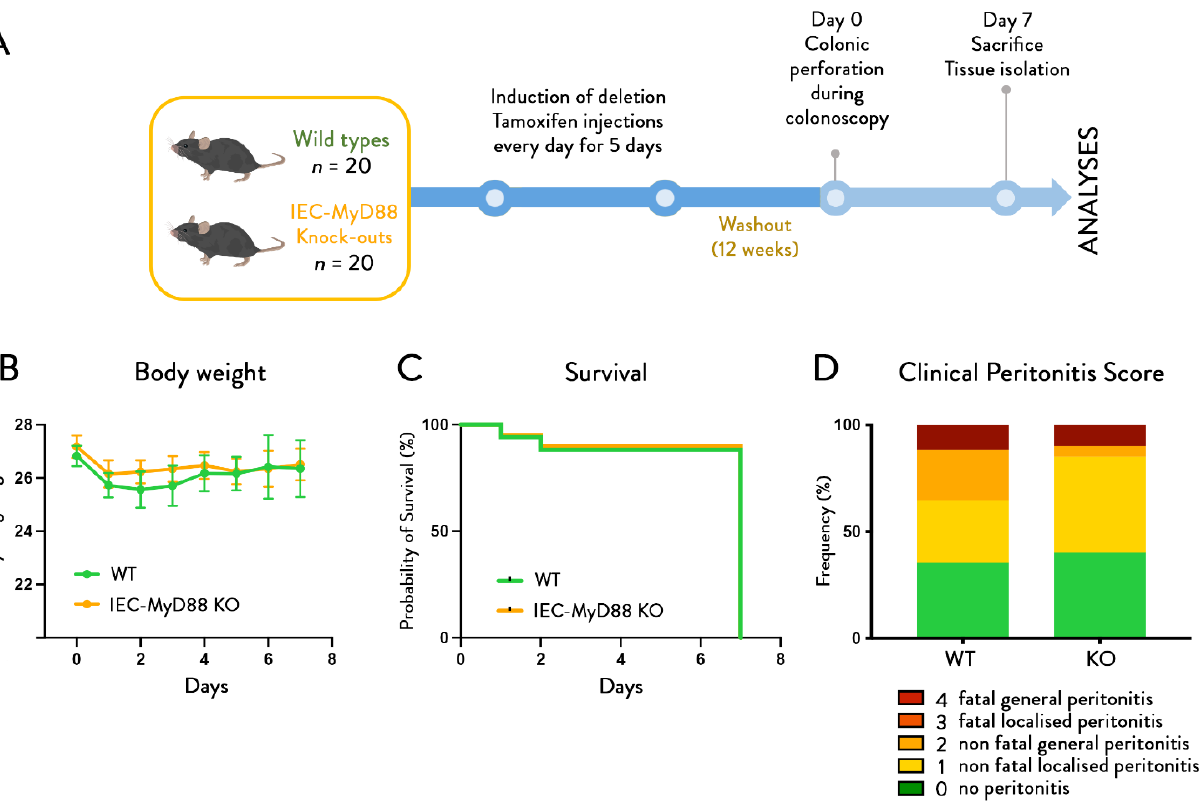
Figure 5. Mice with intestinal-epithelial-cell-specific deletion of Myd88 are similarly sensitive as wild-type mice to mortality and peritonitis. ( A ) Experimental design. ( B ) Body weight evolution, ( C ) survival rates, and ( D ) peritonitis scores after colonic perforation in control mice and mice with an intestinal-epithelial-cell-specific deletion of Myd88 (IEC-villinMYD88 knock-outs ( n = 20 per group). Data are shown as mean ± SEM. Probability of survival assessed using Gehan–Breslow–Wilcoxon test and Chi-square test for clinical peritonitis score, p -value >